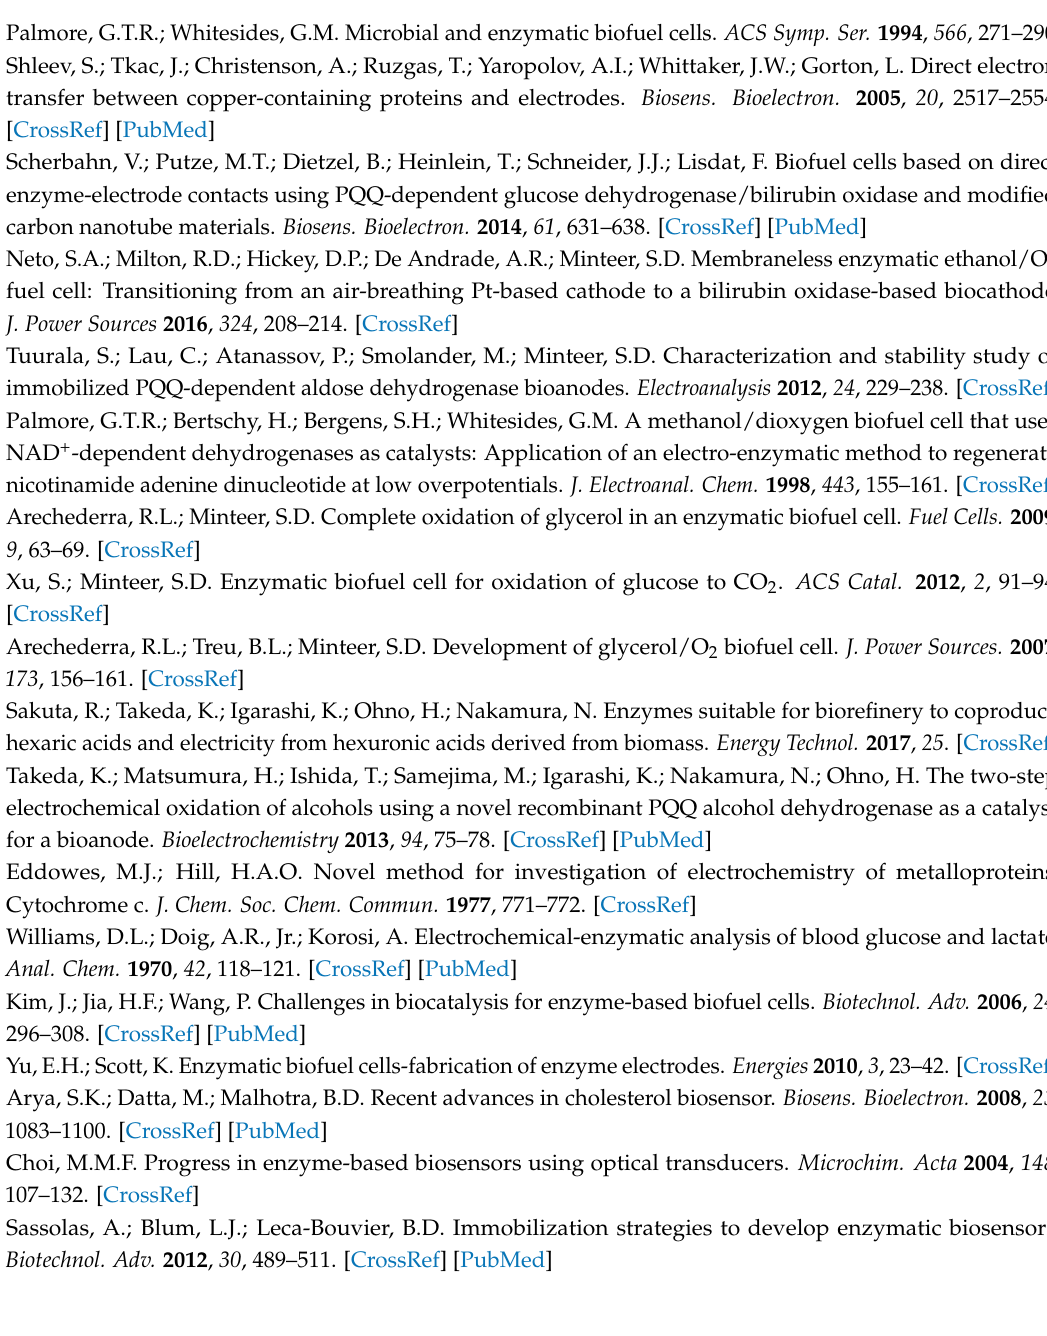
Figure S1: Stability of the Pp ADH modified electrodes, and Figure S2: Cyclic voltammograms of the PGA and PLL modified AuNPs